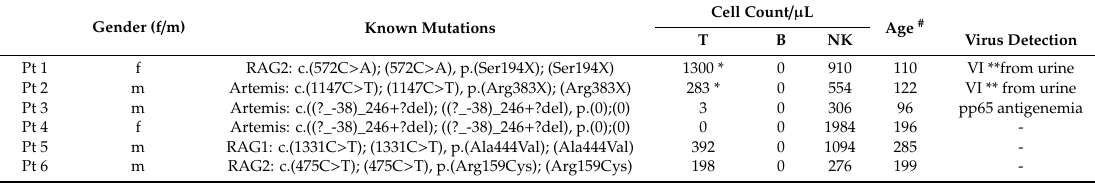
Table 1. Characterization of studied